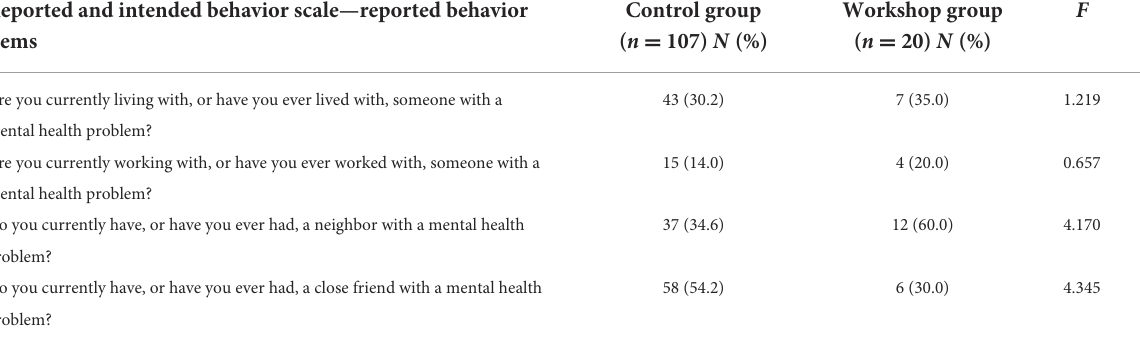
TABLE 2 Results for the reported and intended behavior scale—reported behavior items at study onset by